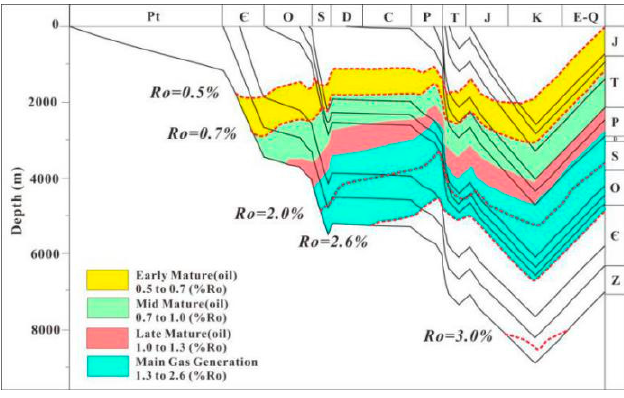
Figure9. HydrocarbongenerationhistoryintheSoutheastChongqing(modifiedfromZhao et al., Figure 9. Hydrocarbon generation history in the Southeast Chongqing (modified from Zhao et al., 2018).